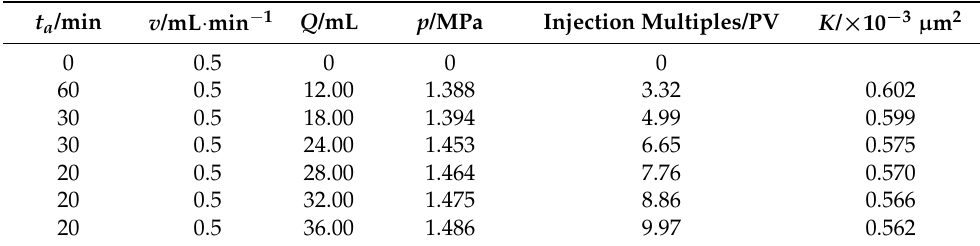
Table 4. Saturated water experimental results.